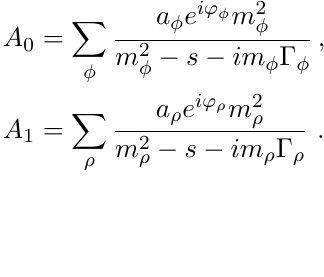
In order to calculate the form factors we need to combine the isospin I = 0 ( φ ) and I = 1 ( ρ ) contributions, corresponding to A